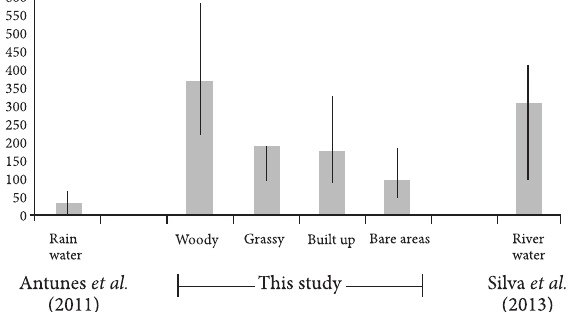
Fig. 3. Variation of values of electric conductivity (in m S/cm –1 ) according to the compartments in study